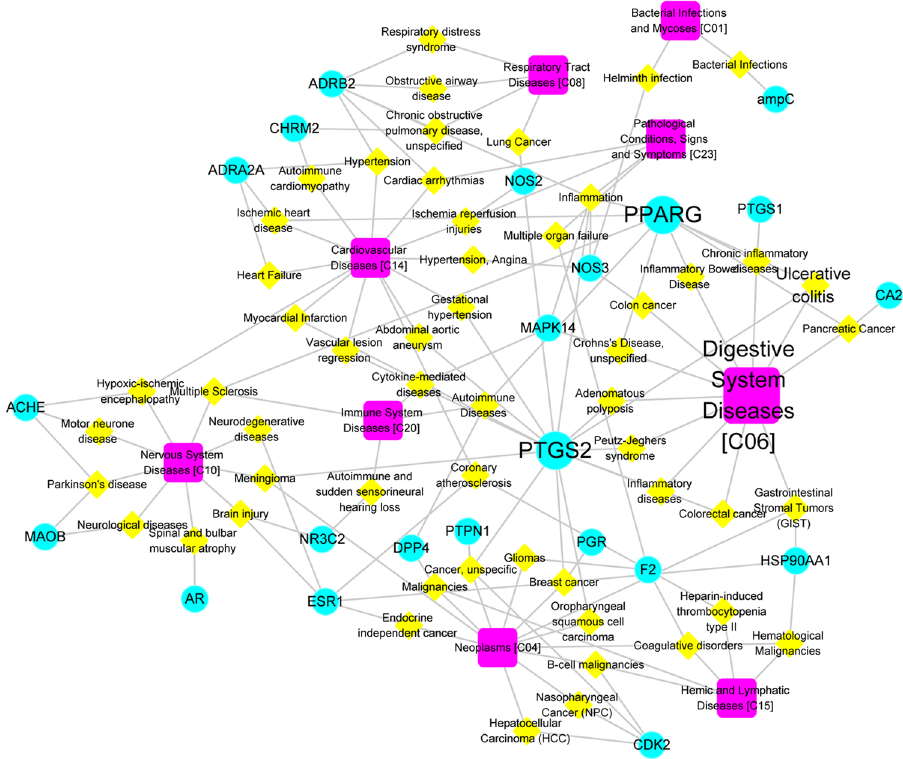
Figure 5. T-D network of Turkish galls. The T-D network is built by a target and diseases. Node size is proportional to its degree. The light green circles indicate the targets of Turkish galls, the yellow diamonds indicate the diseases that may be treated using Turkish galls, and the pink rounded rectangles indicate the disease types.